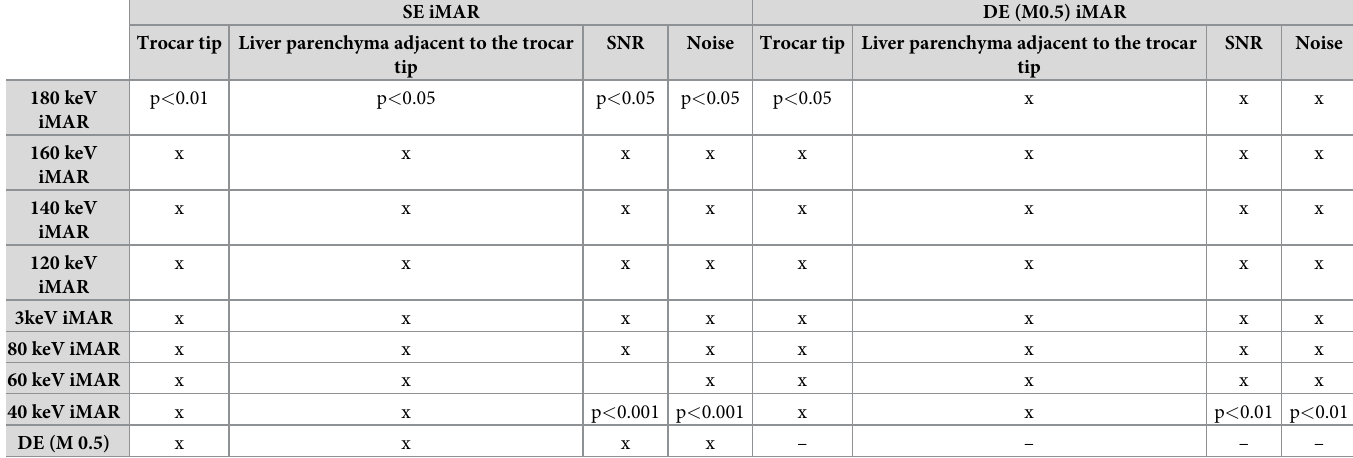
Table 2. Crosstable for p-values based on HU measurements at the trocar tip and liver parenchyma adjacent to the trocar tip, SNR and noise on axial images with VMSI, SE I30-3 and Q 30–3 with iMAR. Trocar tip Liver parenchyma adjacent to the trocar